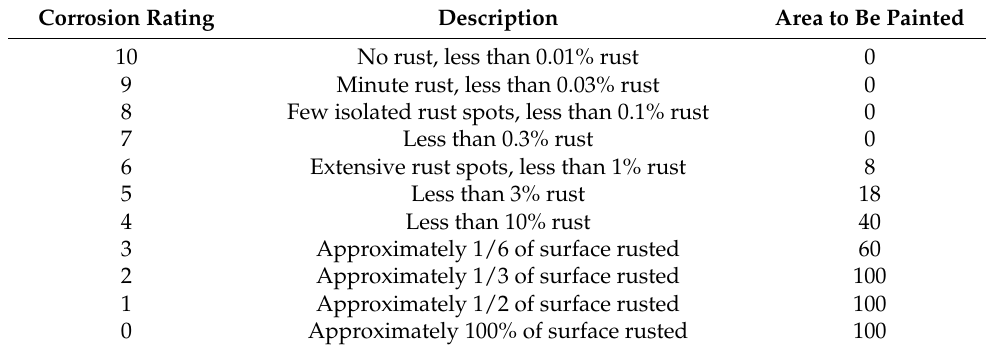
Table 1. Corrosion performance rating based on ASTM